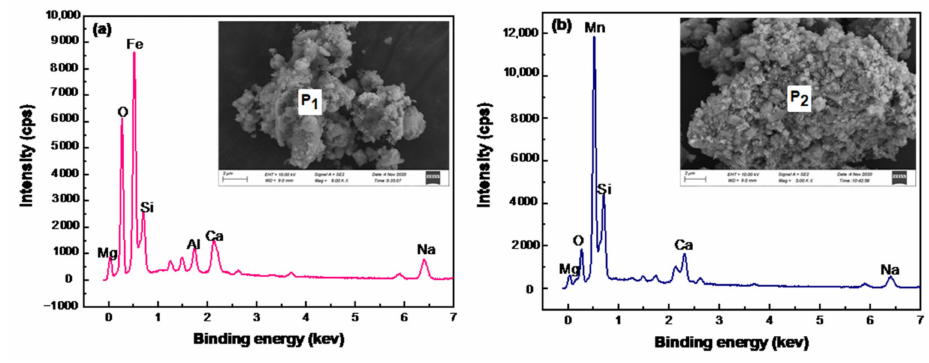
Figure 9. SEM–EDS images of iron concentrate ( a ) and manganese concentrate ( b